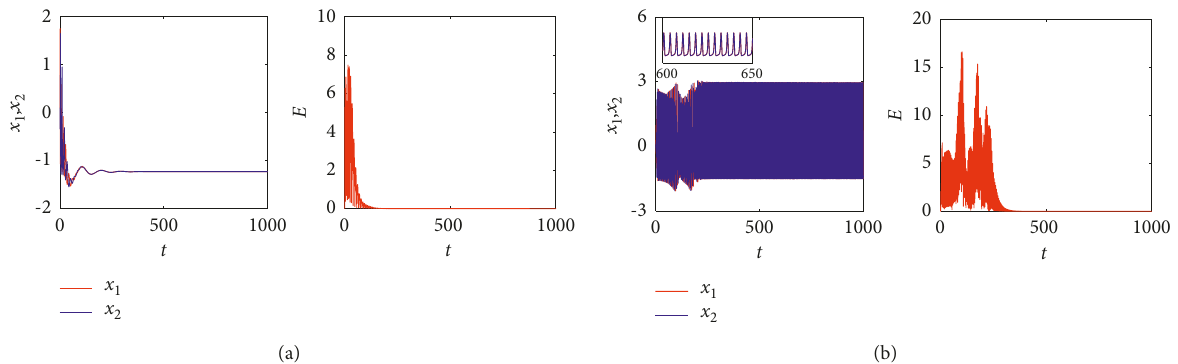
Figure 8: The time series of membrane potentials x and quiescent neurons). For (a) quiescent state synchronization with τ � 0 . 5 and D � 1; (b) periodical firing synchronization with τ � 3 and D � 5. The initial values are selected with (0.1, 0.01, 1.05, 0.1, 0.01, 1.05).